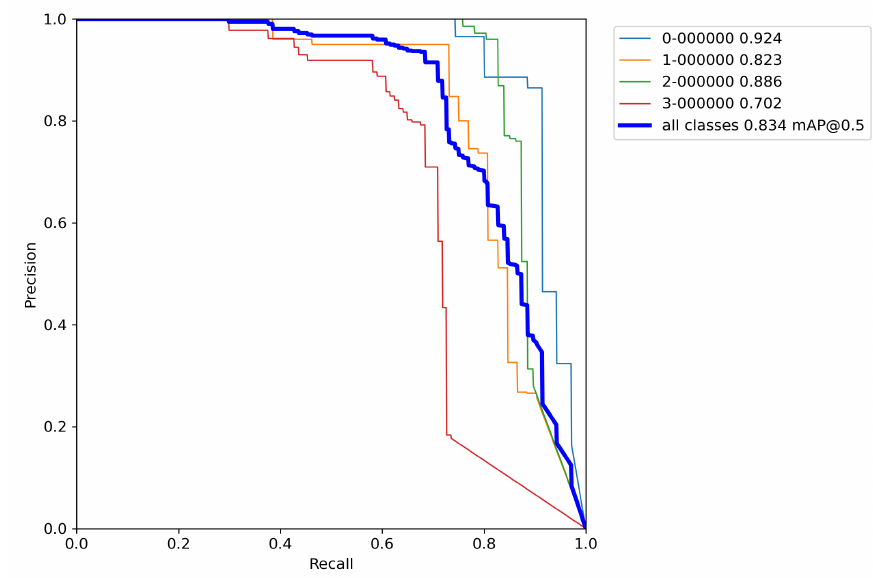
Figure A13. Model trained with augmentation pipeline P–R curve—Experiment